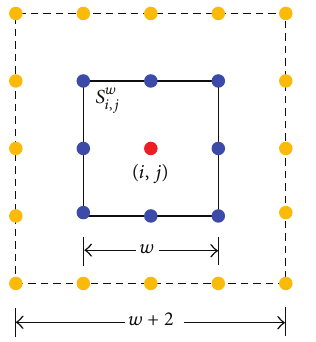
Figure 2: Window size of adaptive median filter (Initialize 𝑤 = 3